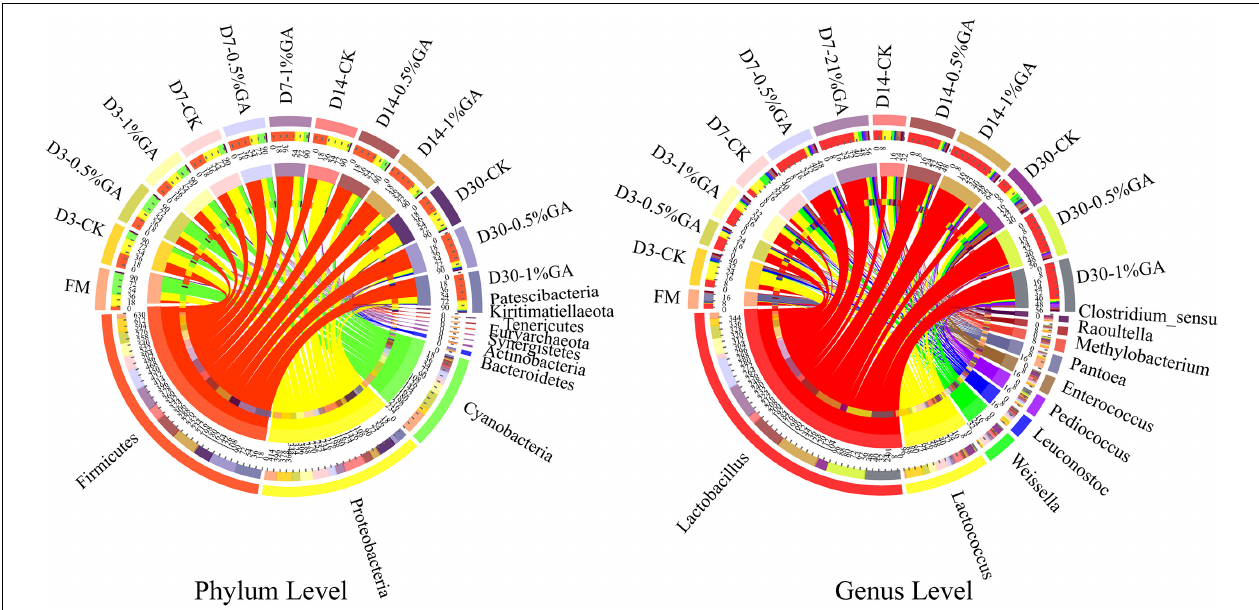
FIGURE 2 | Circos map of bacterial communities at the phylum and genus levels for whole plant soybean silage with and without the addition of gallic acid (GA) (FM, fresh matter; CK, blank control; 0.5% GA, 0.5% FM GA addition; 1% GA, 1% FM GA addition).